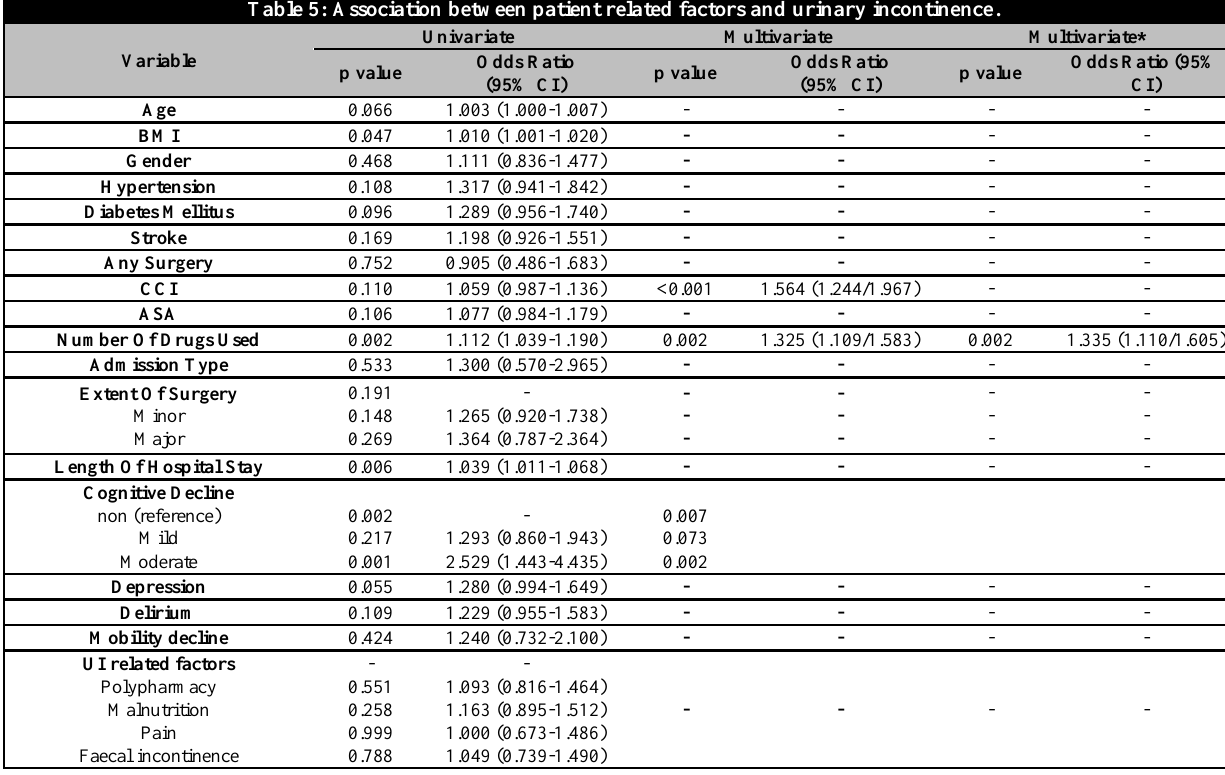
Table 5: Association between patient related factors and urinary incontinence.